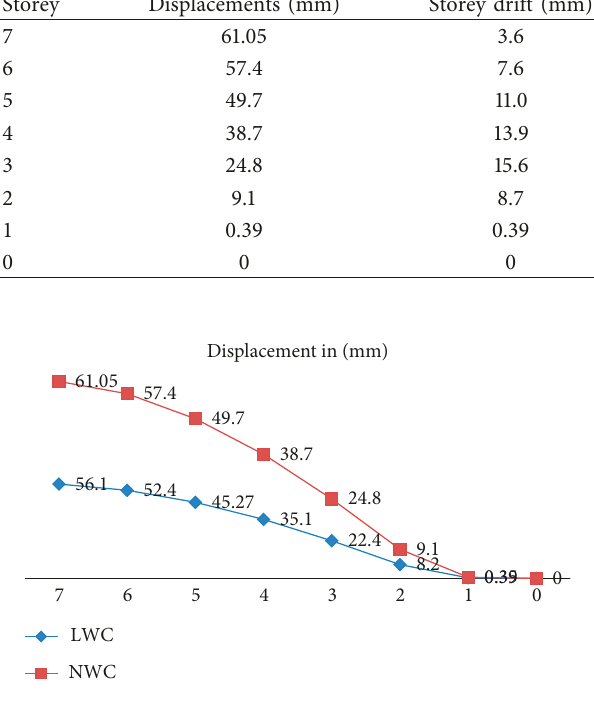
Figure 6: Displacements for each floor for both LWC and NWC structures.